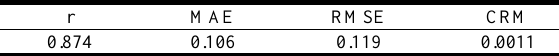
Table 2. Evaluation of K-NN model by some statistical coefficients